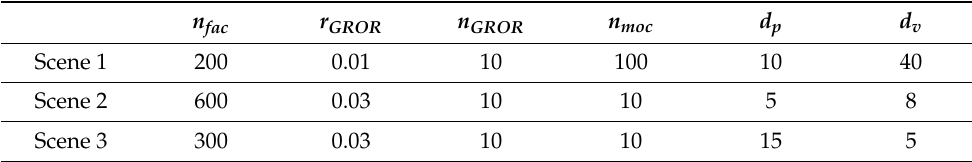
Table 5. Some important parameter settings for the scenarios. n fac